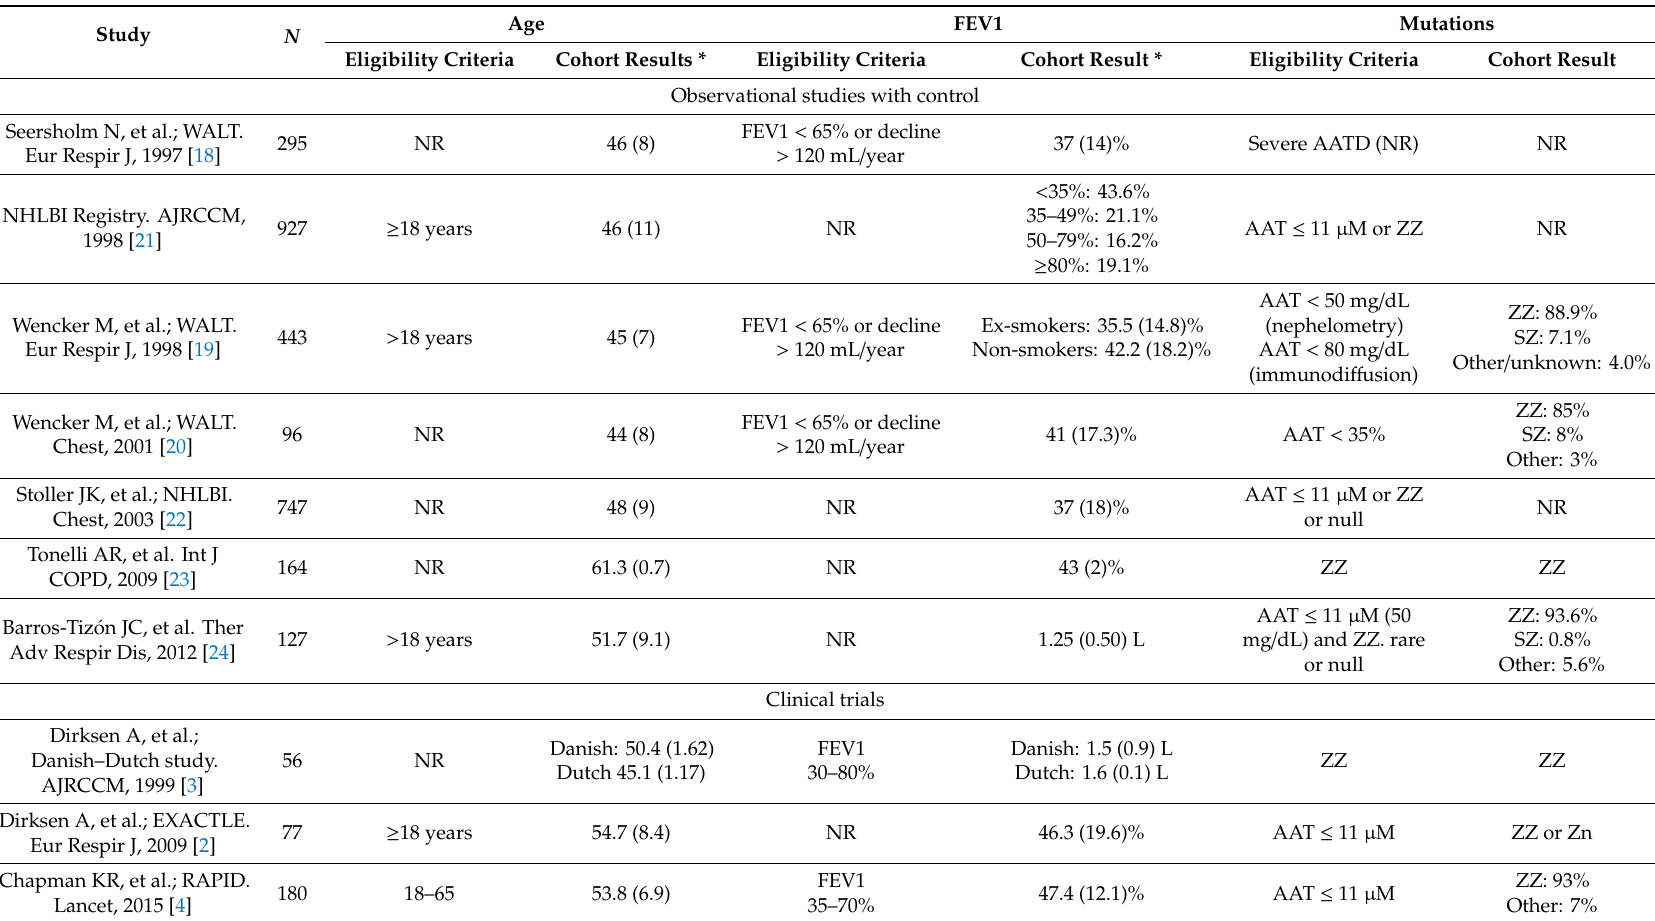
Table 1. Description of the population included in the main studies with augmentation